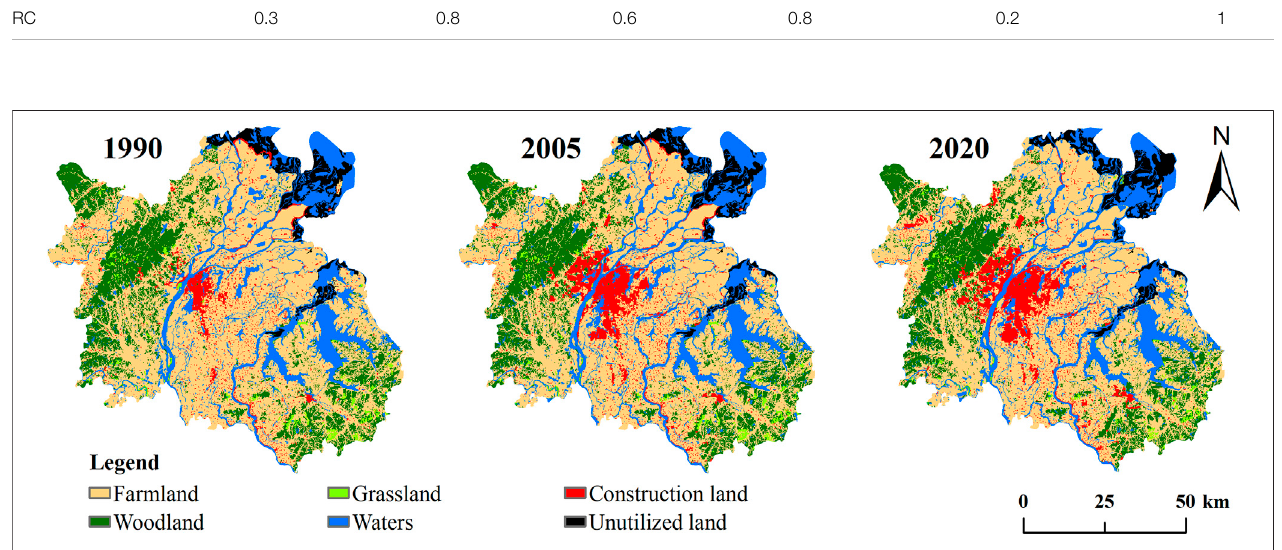
FIGURE 3 | Spatial distribution of landscape types in Nanchang city in 1990, 2005, and